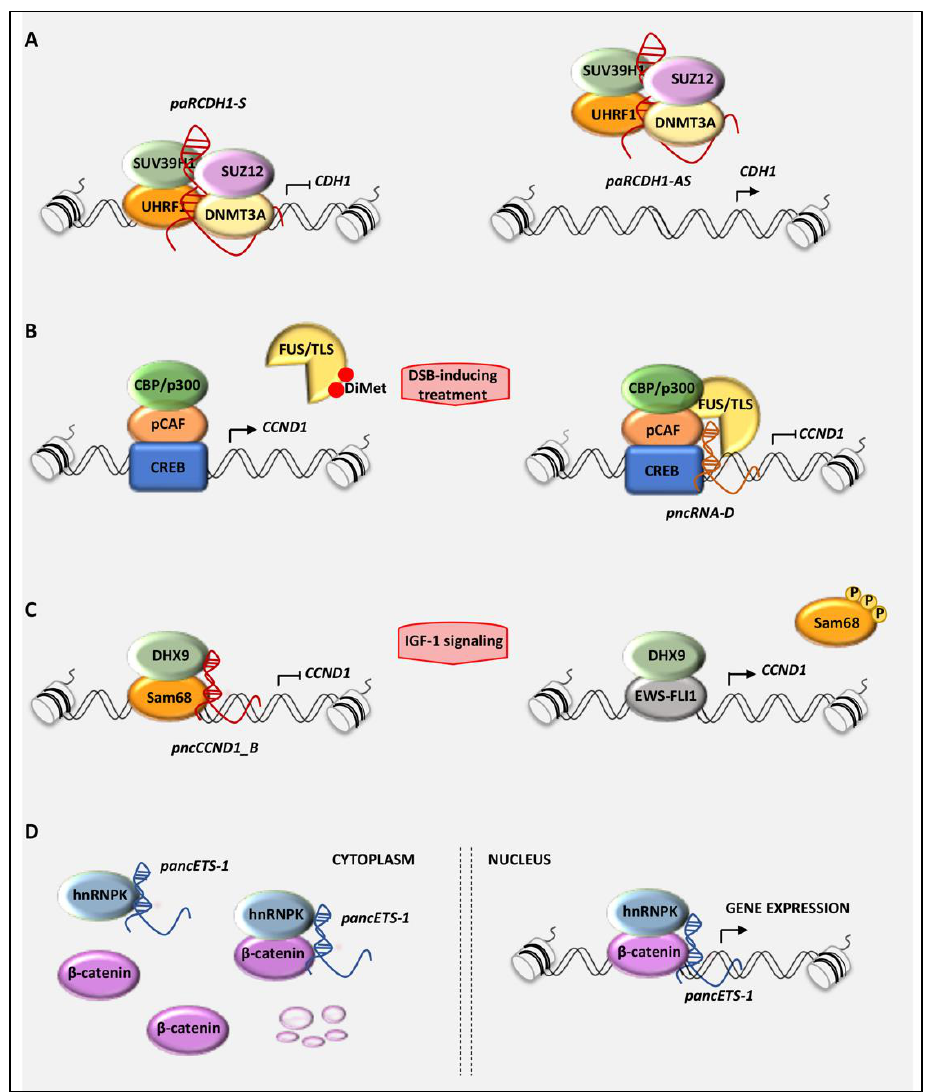
Figure 2. Schematic model of the molecular mechanisms leading to the gene transcriptional regulation mediated by pancRNAs: ( A ) The pancRNAs transcribed in sense orientation from the promoter of the CDH1 gene ( paCDH-1S ) repress CDH1 expression, whereas those antisense-directed ( paRCDH1-AS ) increase CDH1 levels by preventing the repressive recruitment of specific epigenetic complex on the CDH1 promoter. ( B ) pncRNA_D represses the transcription of CCND1 by recruiting FUS/TLS (fused in sarcoma/translocated in liposarcoma) on the CCND1 promoter, which in turn inhibits the histone acetyl-transferase (HAT) activity of CBP/p300. ( C ) In Ewing sarcoma cells, pncCCND1_B assembles a repressive complex formed by DHX9 and Sam68 on the CCND1 promoter to repress CCND1 transcription. On the contrary, the mitogenic stimulation with IGF-1 dissociates this complex, favoring the EWS-FLI1/DHX9-dependent transcription of CCND1. ( D ) In cancer cells, pancEts-1 interacts with heterogeneous nuclear ribo-nucleoprotein K (hnRNPK), promoting the stabilization and transactivation of β-catenin.